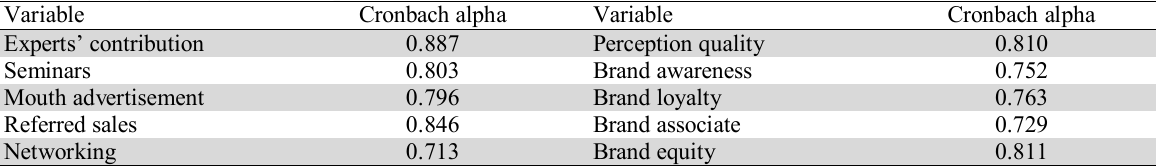
The summary of Cronbach